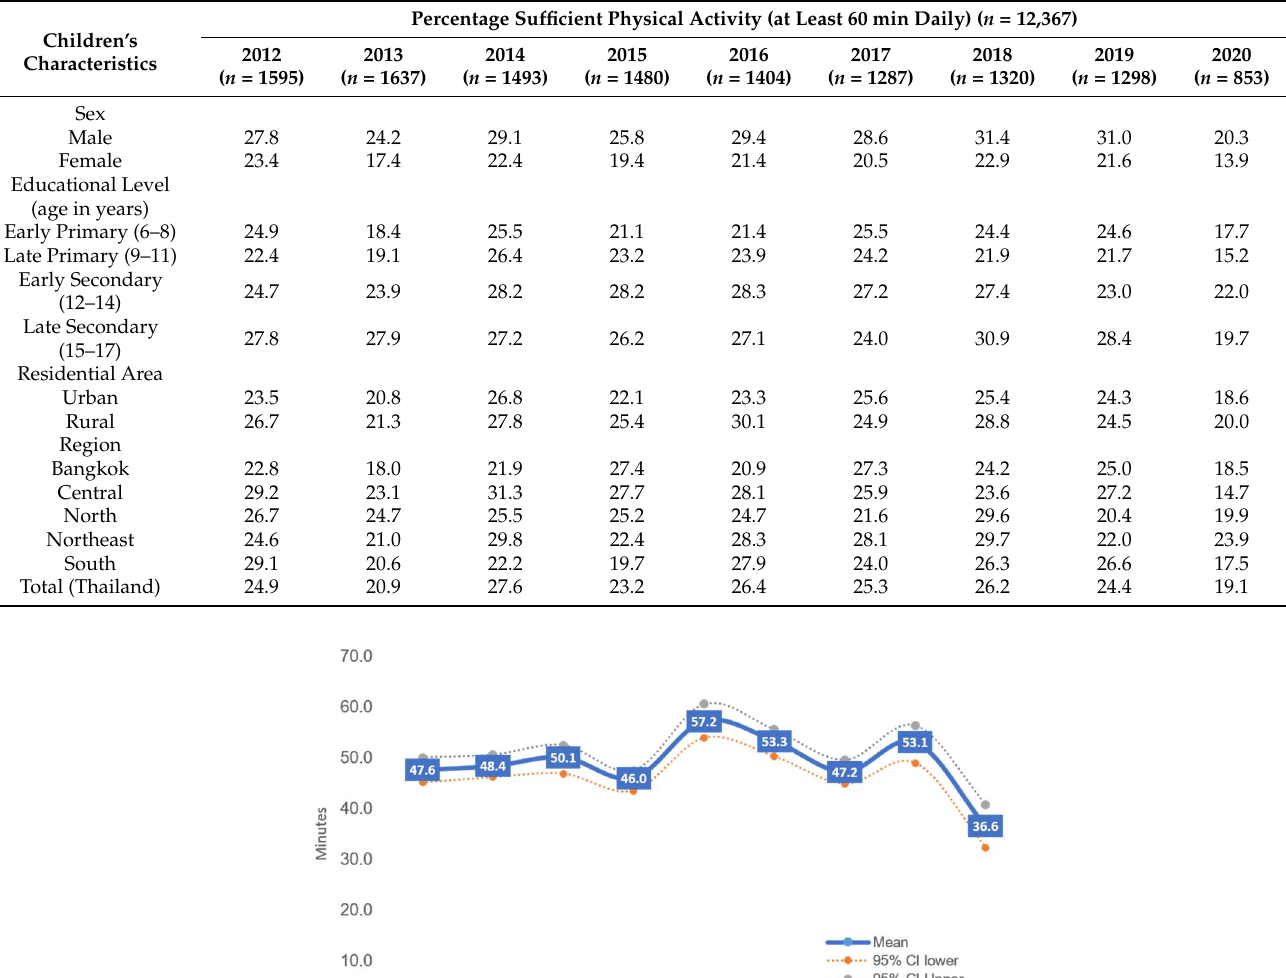
Table 2. Prevalence of sufficient MVPA among Thai children and young people: 2012–2020. Children’s Characteristics